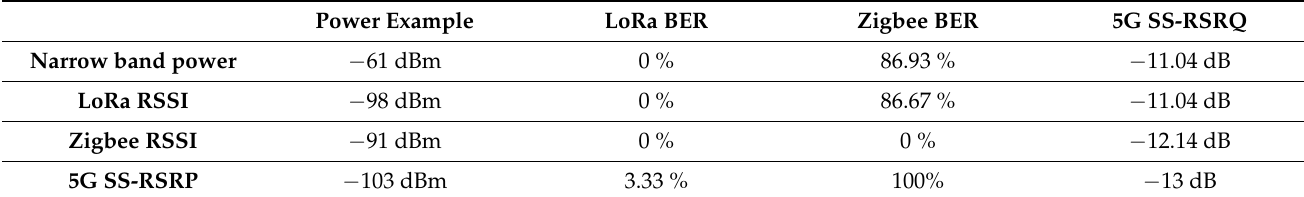
Table 5. BER for examples of received power values for each